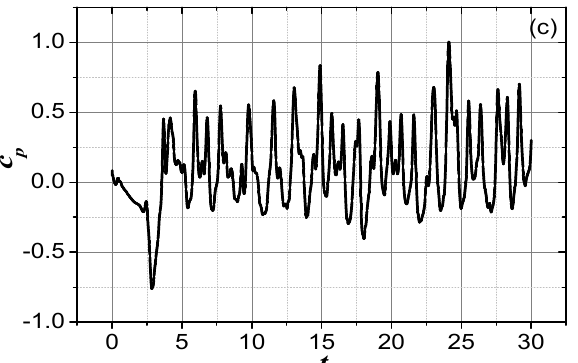
Figure 3. Waveforms of the three types of signals (( a ) circular target; ( b ) triangular target; ( c ) square